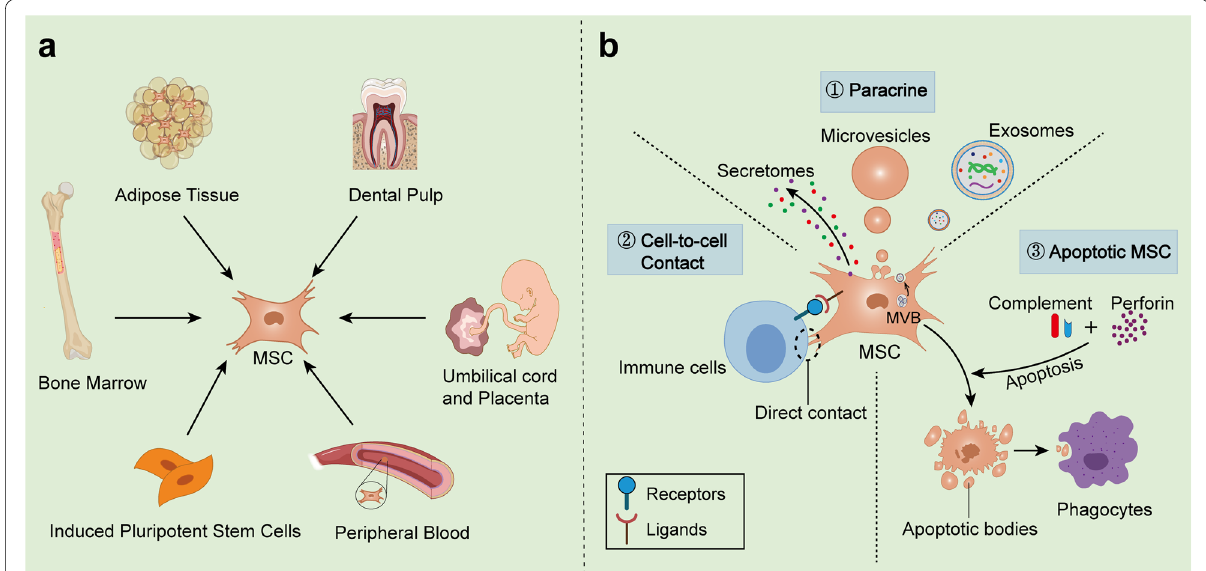
Fig. 5 Sources of MSCs and the Pathways of MSCs exerting immunomodulatory effects. a MSCs can be isolated from the bone marrow, adipose tissue, dental pulp, umbilical cord and placenta, peripheral blood, and induced pluripotent stem cells. b There are three main pathways for MSCs to exert immunomodulatory effects: ① Paracrine effects, including microvesicles, exosomes and bioactive molecules; ② Cell‑to‑cell contact, including direct intercellular contact and intercellular contact mediated by the binding of cell surface receptors and ligands; ③ Apoptotic MSCs: MSCs are attacked by complement system components, complement activated neutrophils and perforin positive cytotoxic cells, then phagocytes engulf apoptotic MSCs to mediate immune